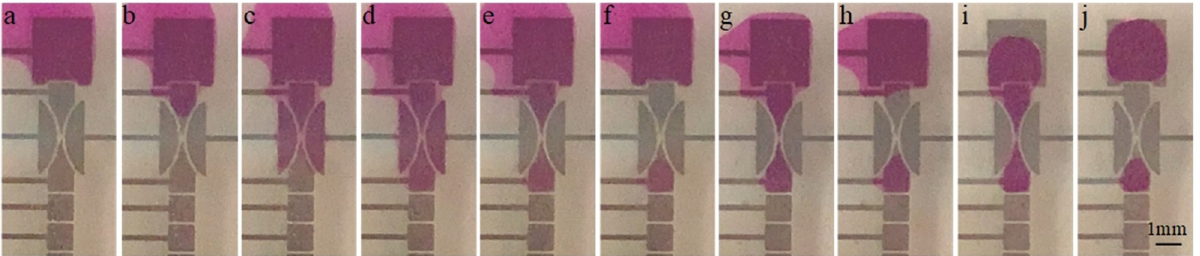
Figure 7: Series of video frames about droplet dispensing using the optimized electrodes scheme with the cutting electrodes radius R = 2.0 mm ( Video S2 ) ; ( a – f ) The fi rst droplet was generated; ( g and h ) The fi fth droplet was dispensed; ( i and j ) The tenth droplet was